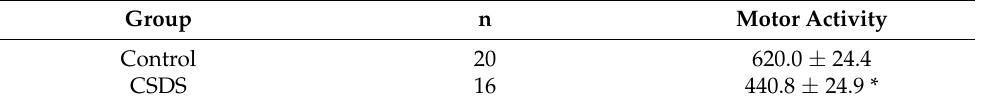
Table 1. Effect of Chronic social defeat stress (CSDS) on locomotor activity in mice.